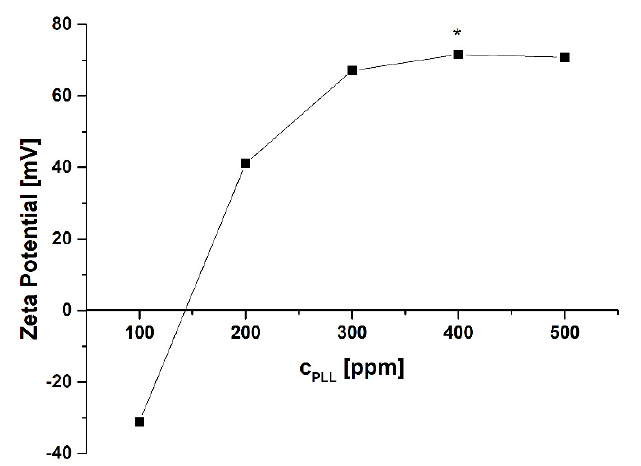
Figure 1. Changes of the zeta potential of prepared nanocores with PLL concentration (PLL—poly(L-lysine), * optimal concentration of PLL).